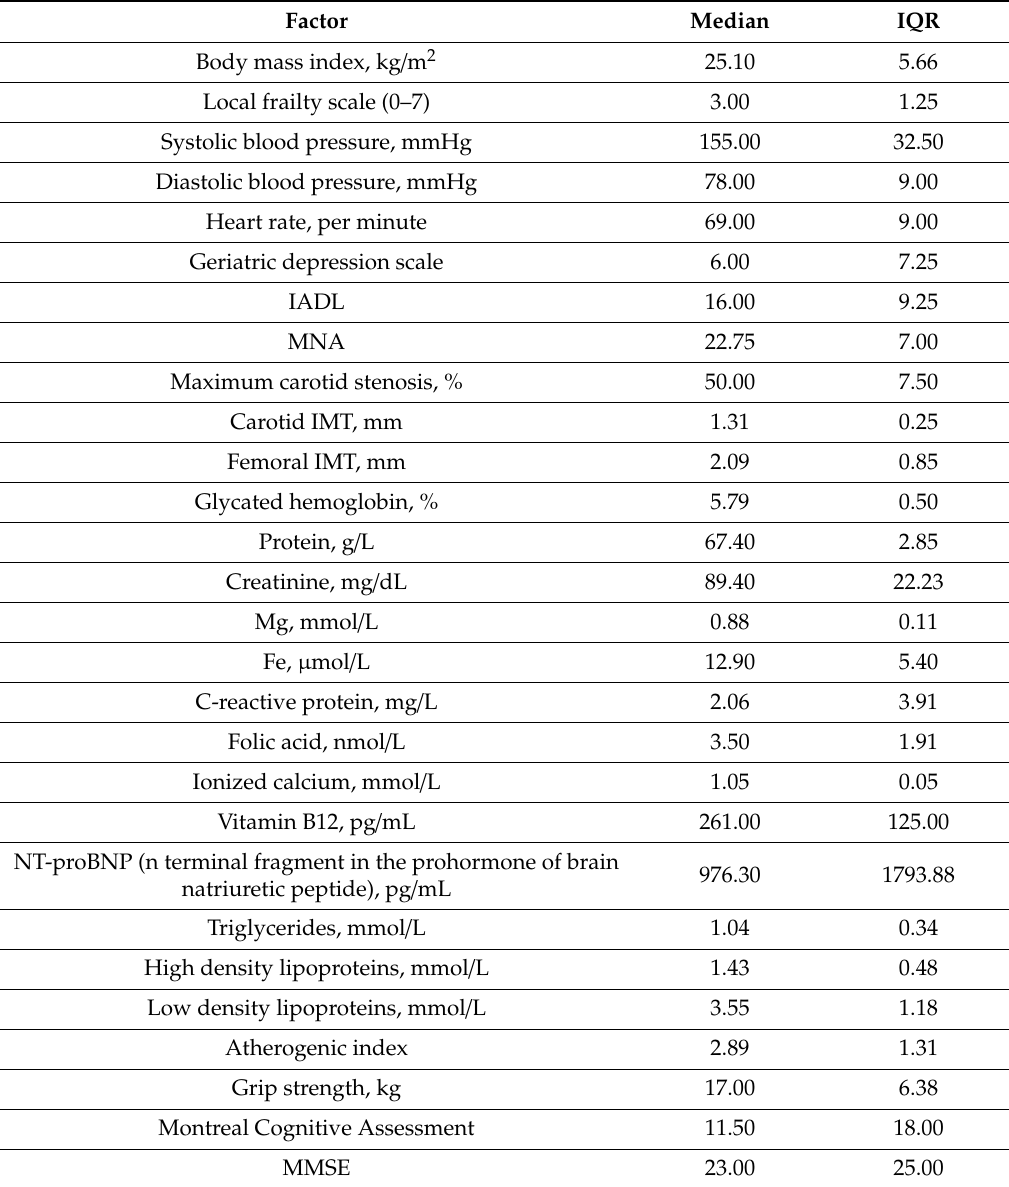
Table 4. Clinical characteristics of the LL